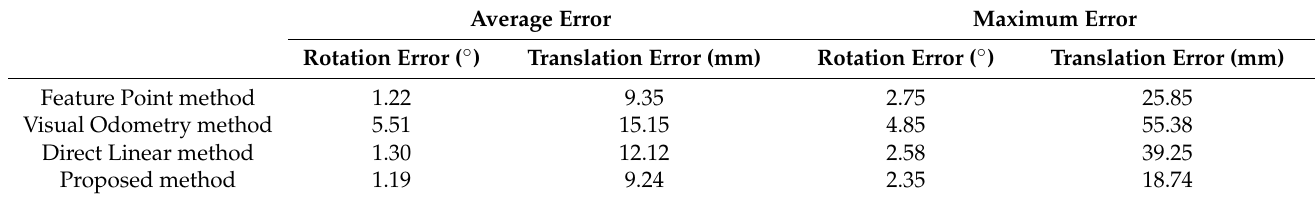
Table 3. Statistics of the static pose estimation experimental